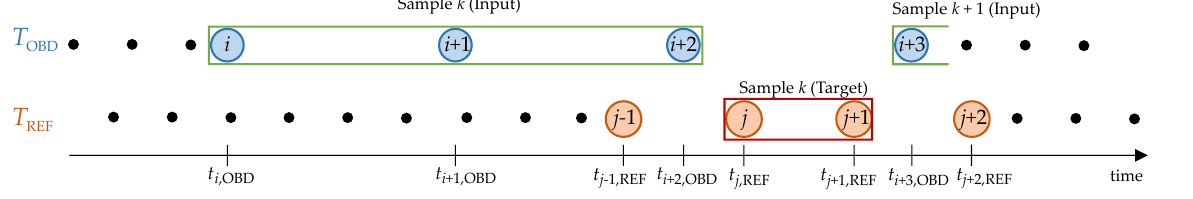
Figure 7. Graphical depiction of the sample generation for L in = 3 . Samples